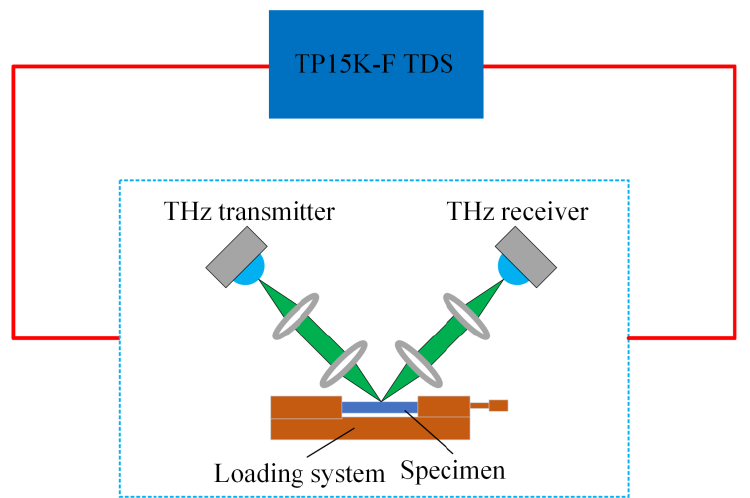
Figure 1. Diagram of the experimental installation for the measurement of the stress optical coeffi- cient.